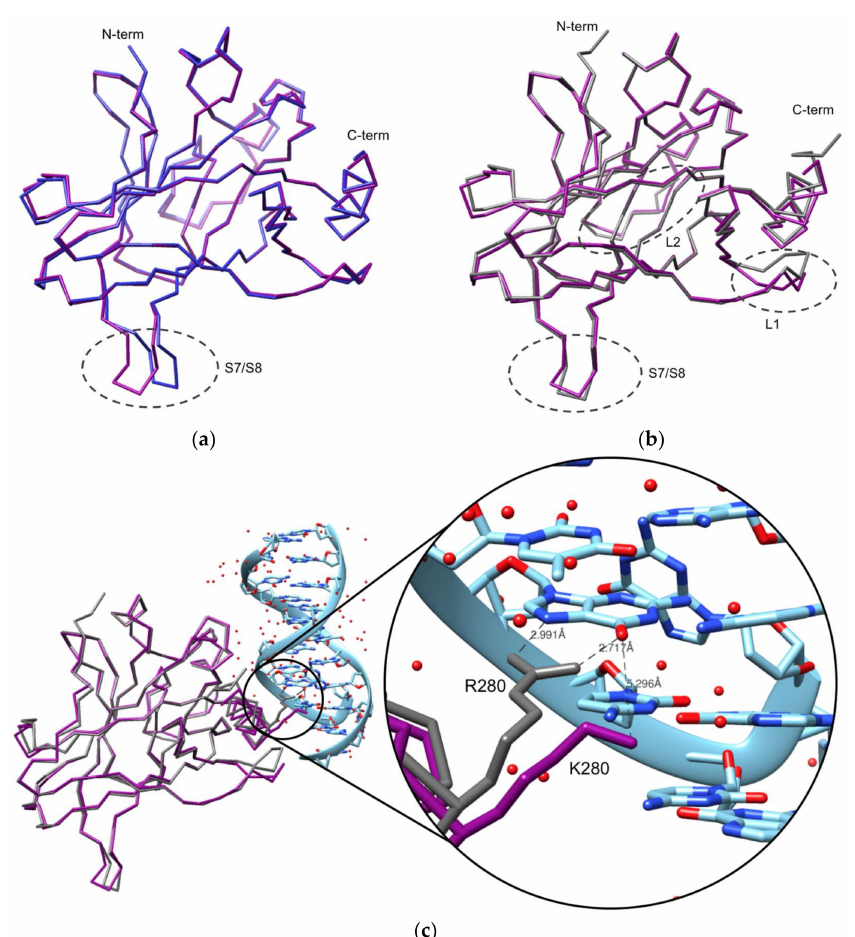
Figure 2. Comparison of p53R280K DBD (backbone in purple) with ( a ) human DNA-free (2OCJ, blue) and ( b ) DNA-bound (2AC0, gray) wt p53 DBD structures. Regions with the highest structural variations are encircled by gray dashed lines. In ( a ), the S7/S8 turn is the region with the highest structural variation, while in ( b ), the S7/S8 turn, L1 loop, and L2 loop are the regions with the most significant structural differences. The L2 loop is located at the back in this figure. ( c ) Backbone superposition of p53R280K DBD (purple) with the p53 DBD in complex with DNA (2AC0, gray). The double-stranded DNA is represented in cyan blue. The side chains at position 280 are shown in both structures, lysine from mutant p53 and arginine from wt p53. The hydrogen contacts between the R280 and guanine, and a hypothetical contact between K280 and guanine, are represented by gray dashed lines; carbon atoms are colored light blue, nitrogens are navy blue and oxygens are red. Atomic distances are